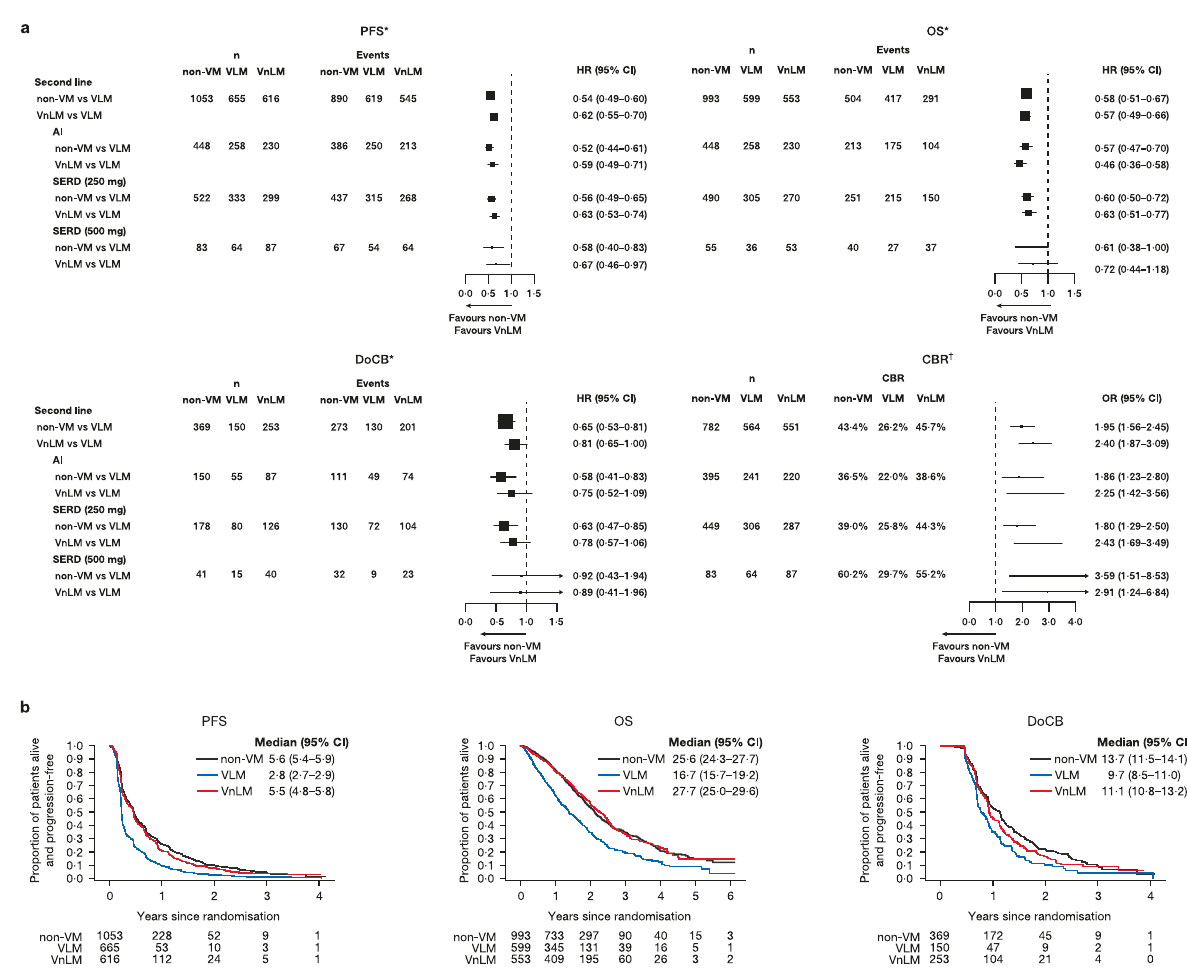
Fig. 7 Clinical outcomes for non-VM and VnLM versus VLM in the second-line setting. a Forest plots of PFS, OS, DoCB and CBR. * Fixed effect for trial was fi tted in all models. † Fixed-effect model was fi tted to the AI SERD 250 mg and SERD 500 mg data; random effects for trial were included in the models for all data. § “ one − stage ” fi xed − effects logistic regression models. b Projected probability of PFS, OS and DoCB. Median (95% CI) PFS/OS/DoCB in months. AI aromatase inhibitor, CBR clinical bene fi t rate, DoCB duration of clinical bene fi t, HR hazard ratio, n number of patients, non-VM non-visceral metastases, PFS progression-free survival, OR odds ratio, OS overall survival, SERD selective estrogen receptor degrader, SERM selective estrogen receptor modulator, VLM visceral liver metastases, Non-VM non-visceral metastases, VnLM visceral non-liver metastases. VLM vs VnLM vs non-VM. PFS: AI: Interaction test p = 0.15; SERD (250): Interaction test p = 0.18; SERD (500): Interaction test p = 0.05; All: Interaction test p = 0.06. OS: AI: Interaction test p = 0.66; SERD (250): Interaction test p = 0.98; SERD (500): Interaction test p = 0.98; All: Interaction test p = 0.78. DoCB: AI: Interaction test p = 0.59; SERD (250): Interaction test p = 0.10; SERD (500): Interaction test p = 0.11; All: Interaction test p = 0.03.CBR: AI: Interaction test p = 0.90; SERD (250): Interaction test p = 0.20; SERD (500): Interaction test p = 0.33; All: Interaction test p =